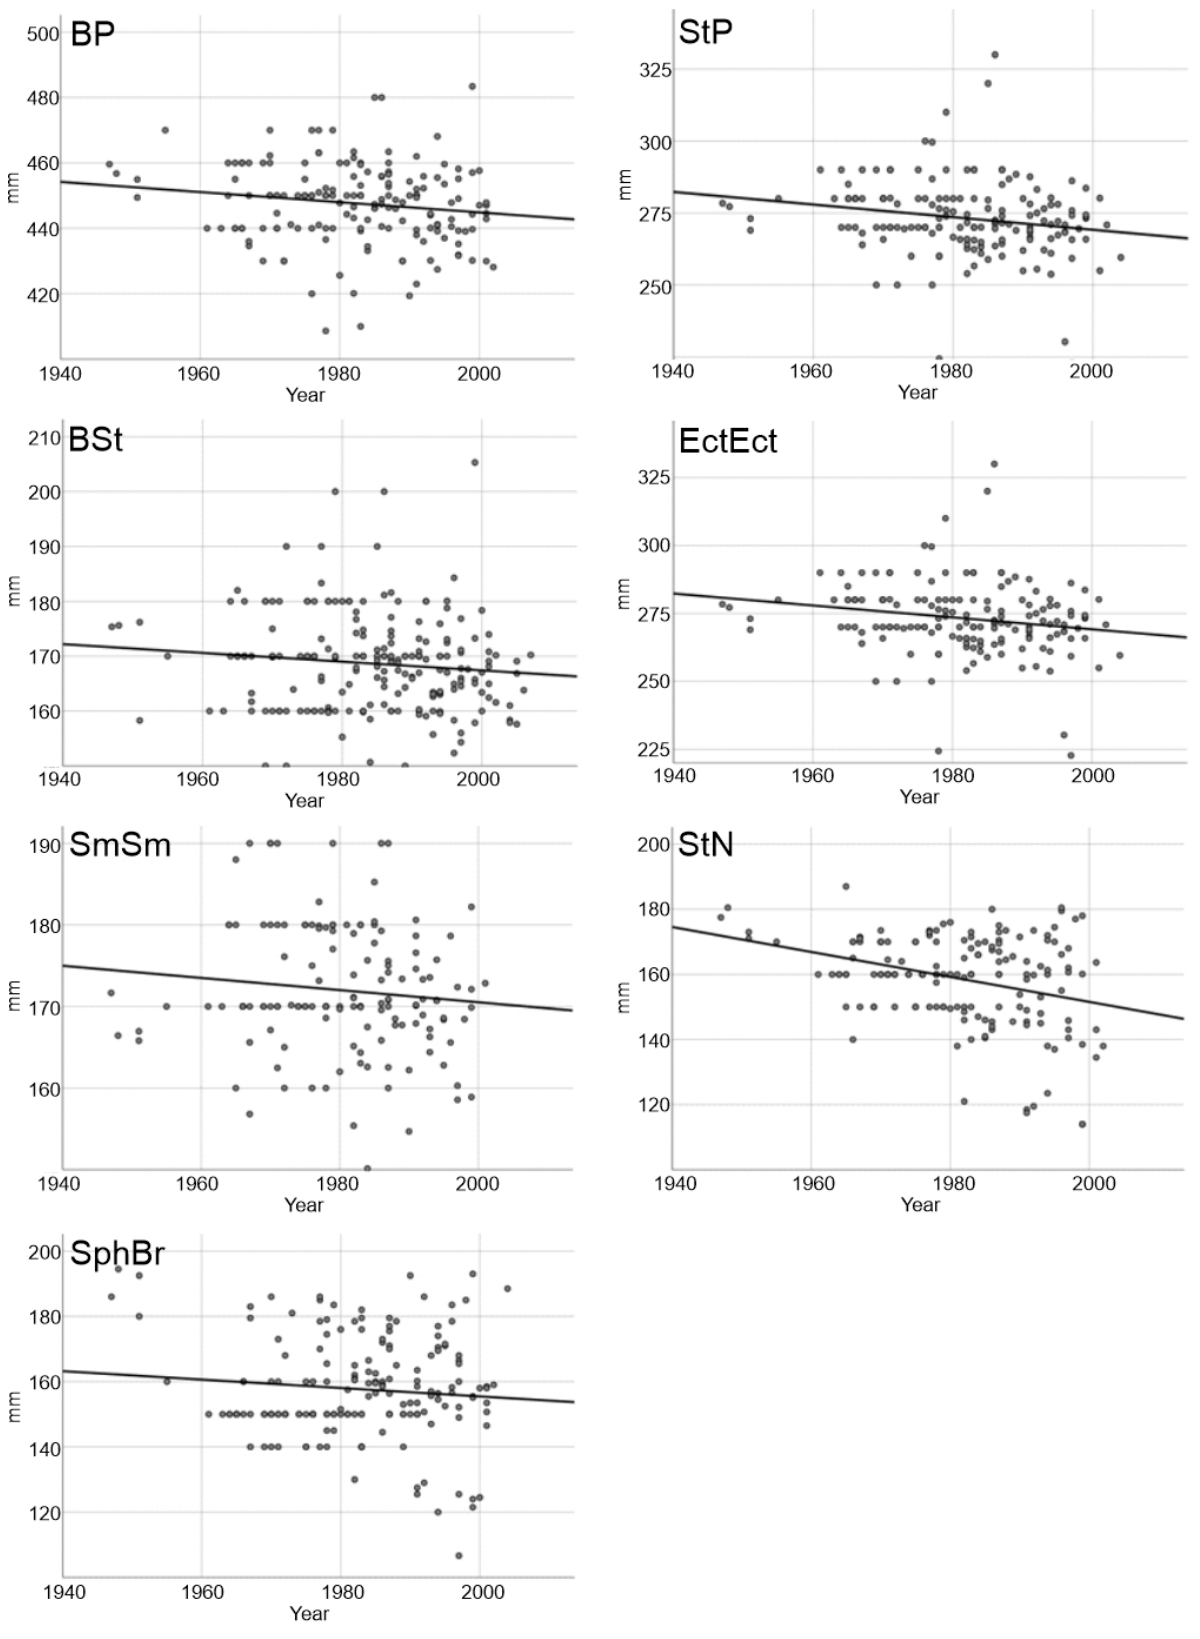
Figure 4. Trends in cranial dimensions change over time in females of European bison.